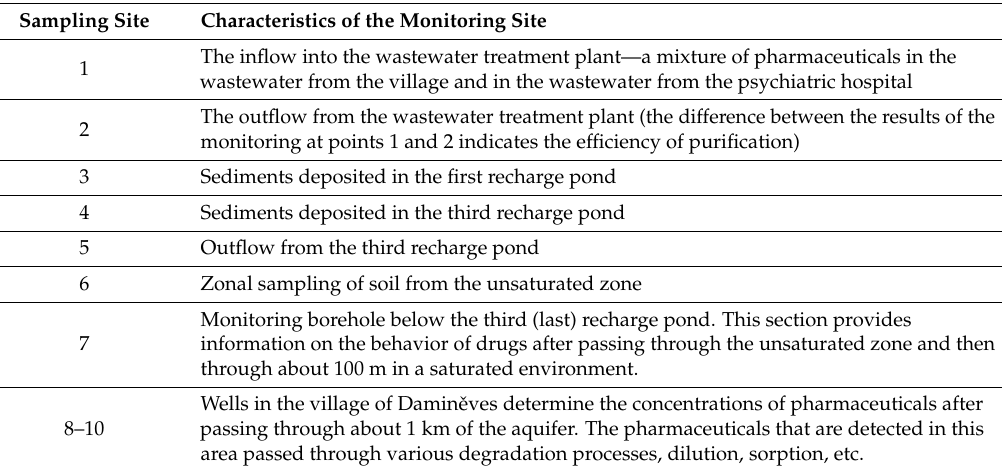
Table 1. Characteristics of the individual monitoring